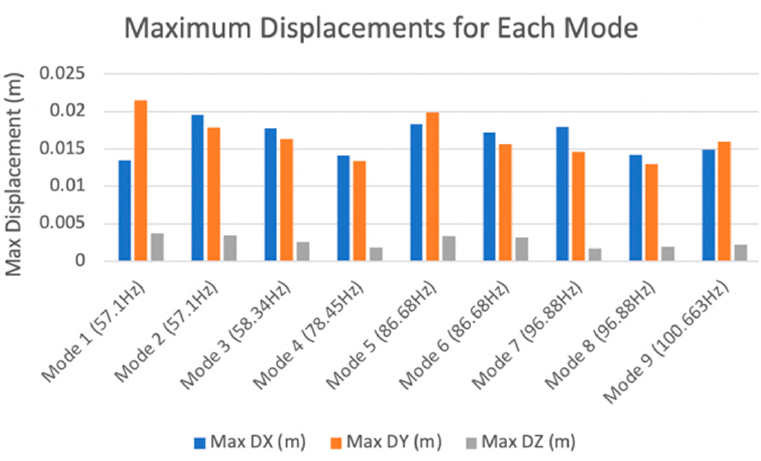
Figure 16. Maximum vertical and lateral nodal displacement for each mode.